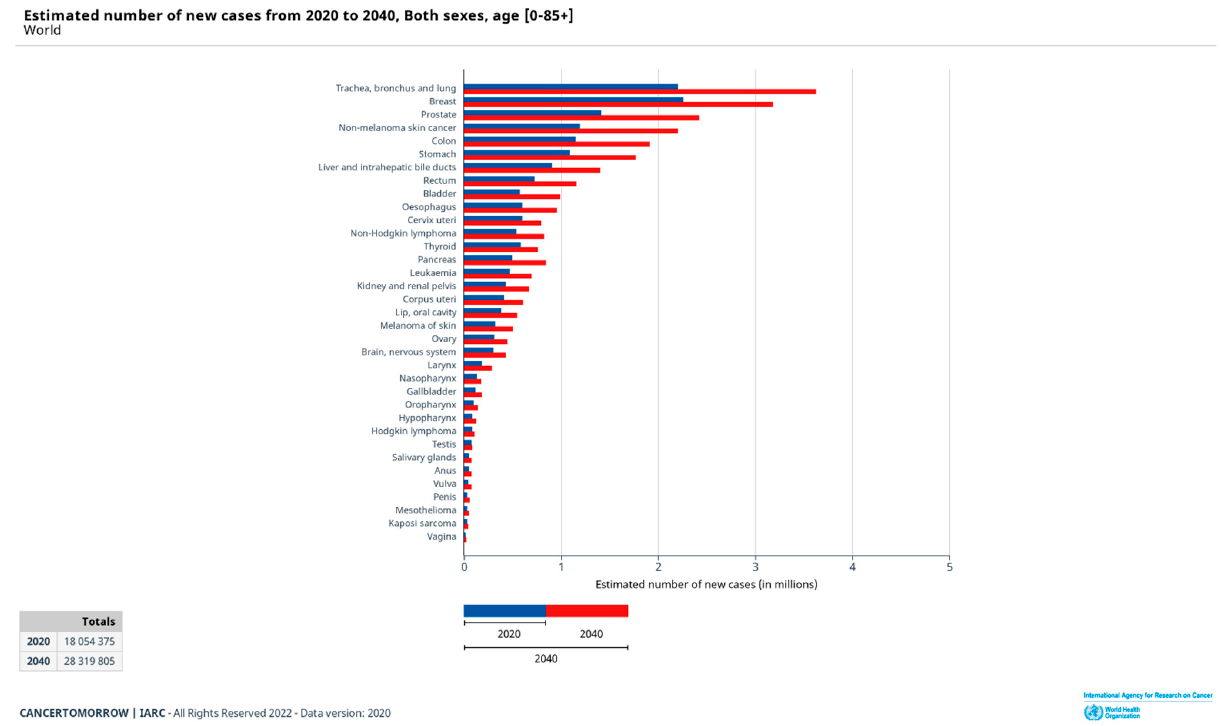
Figure 1. Estimated number of new cancer cases worldwide from 2020 to 2040 [1].